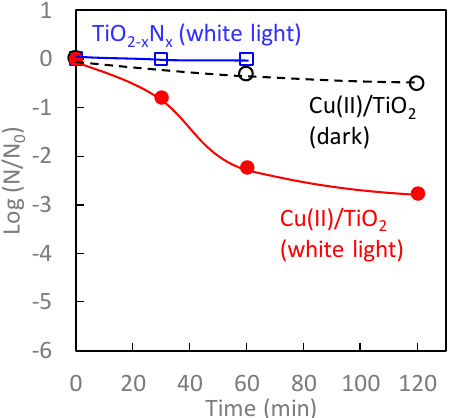
Figure 8. Antiviral bacteriophage Q β for Cu(II)/TiO 2 under dark (black), TiO 2-x N x under white-light irradiation (blue), and Cu(II)/TiO 2 under white-light irradiation (red). Light irradiation was conducted using a commercial 10 W cylindrical white fluorescent lightbulb (FL-10, Mitsubishi) with a UV cut-off film shorter than 400 nm at an illuminance of 800 lux, which was measured by photometer (Topcon IM-5).